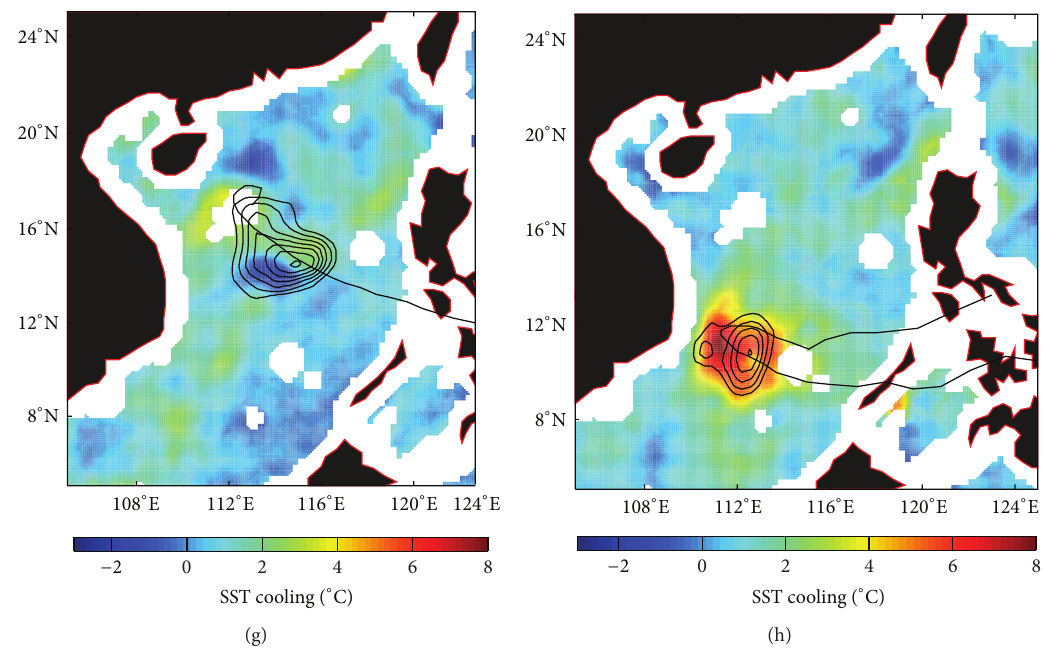
Figure 11: The SST cooling under the influence of typhoons in the CCE area. The thick black solid lines in figures are typhoon tracks. The closed contours are the CCEs influenced by typhoons. The colorbar is the temperature difference before storm and after storm; the exact prestorm and poststorm day are from Table 3. (a) Typhoon Leo, (b) Lingling, (c) Nanmadol, (d) Kai-tak, (e) Chanchu, (f) Durian, (g) Utor, and (h) Hagibis. The date of the CCEs is on the day that typhoon passed the